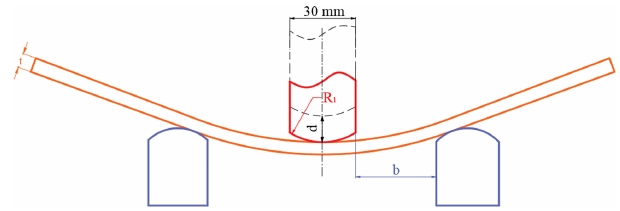
Figure 2. Simplified drawing of local